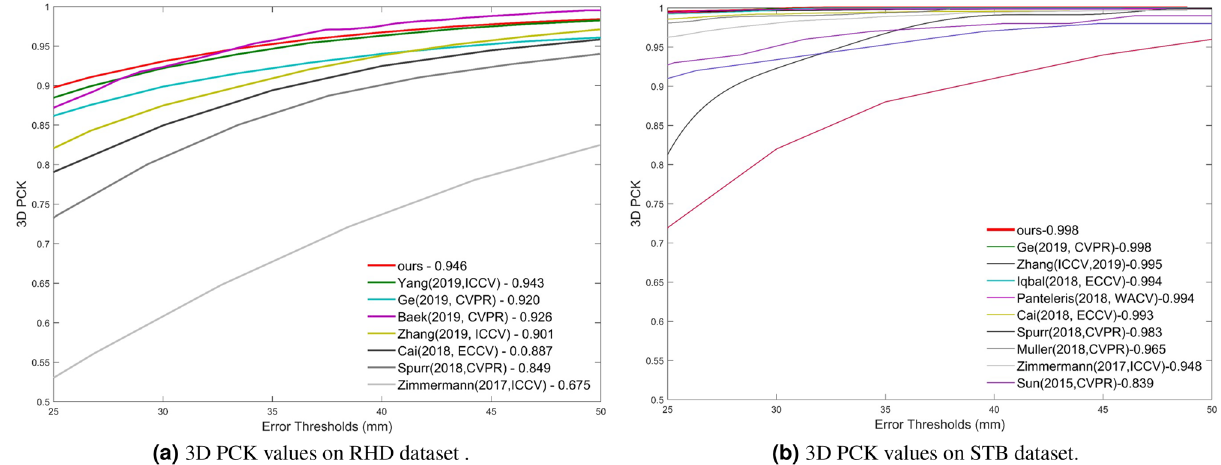
Figure 5. The PCK values that were obtained when comparing our method with the state-of-the-art methods, where our method has comparable results to the state-of-the-art